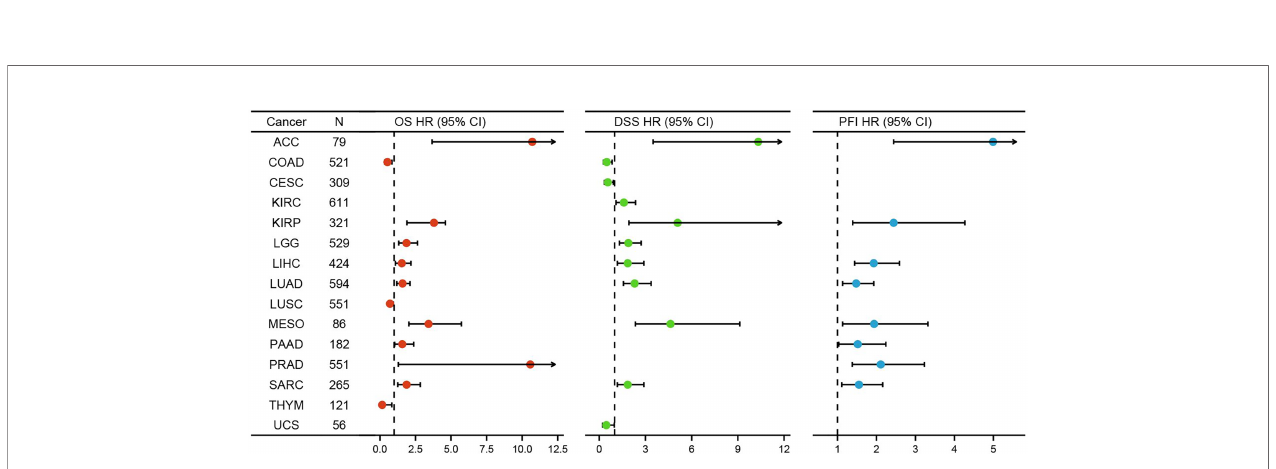
FIGURE 4 | K-M analysis for high- and low- HELLS gene expression in cancers. Forest plot of HELLS OS in 12 cancers (Red), DSS in 11 cancers (Green), and PFI in 8 cancers